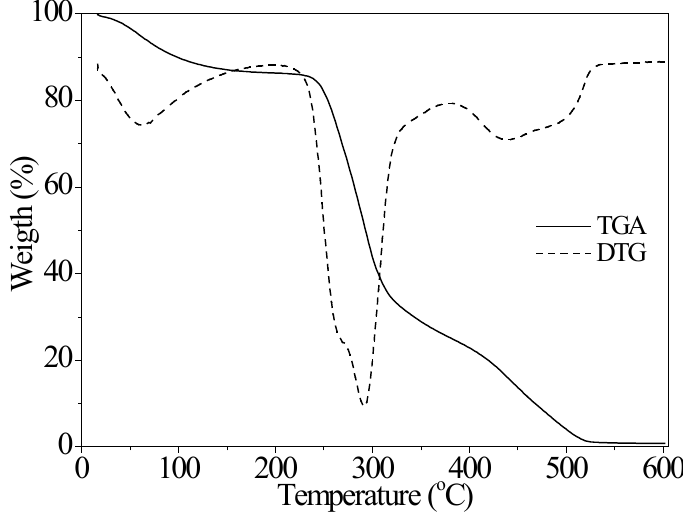
Figure 3. Thermogravimetric curves of BG. Arabinogalactans from gum arabic showed a thermogravimetric peak at 315 ◦ C, which was attributed to the maximum degradation temperature of the gum [56]. According to Al-Maqtari et al. [57], arabinogalactans show moderate temperatures of degradation. This behavior was also reported by Guan and Zhong [58], who observed the thermal degradation of arabinogalactans from gum arabic used as a wall material in the encapsulation process. These results suggest that BG is more suitable to be used in applications that do not involve high